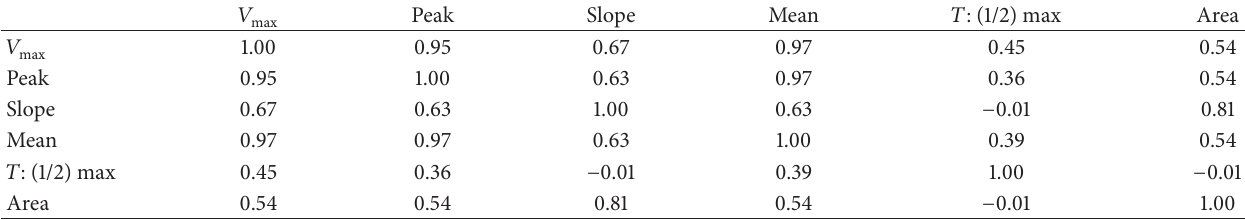
Table 4: Pearson values calculated for 10 𝜇 M of various kinetic parameters.